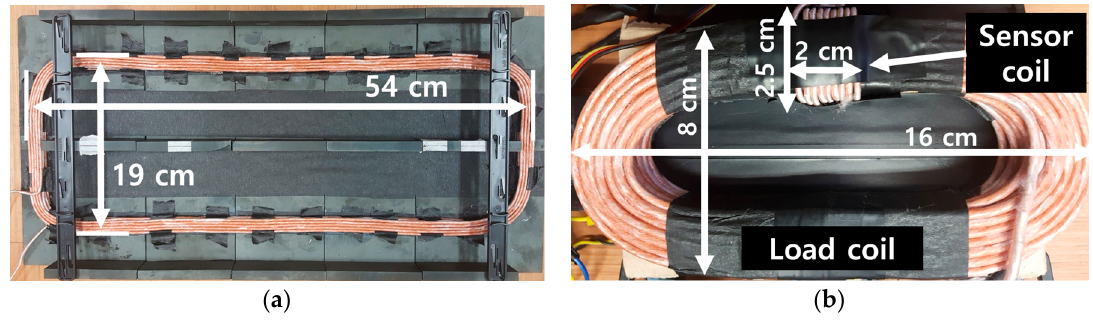
Figure 15. Coil construction of the ( a ) source coil unit and ( b ) load coil/sensor coil unit. Table 2. Dimensions and electrical parameters of the coils used in the experiment.